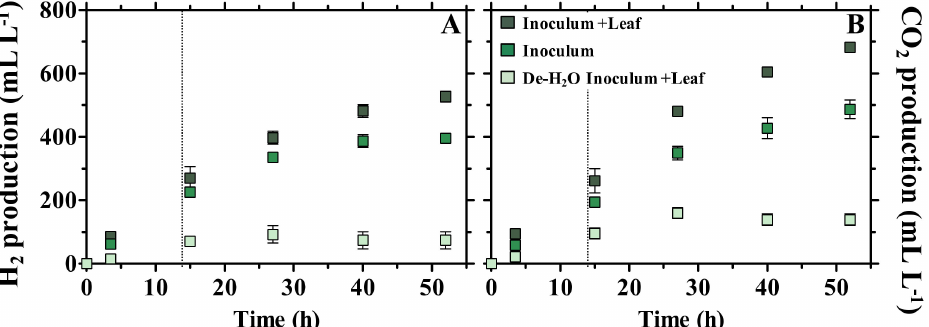
Figure 2. Timeline of gas production of H 2 ( A ) and CO 2 ( B ) in In vitro tests inoculated with gut microbiomes from giant panda fecal samples using different feeding strategies (with or without bamboo leaf; with or without the organics originally found in fecal fluids). The dotted line represents the longest retention time observed in vivo in giant pandas [8]. Keys reported in the